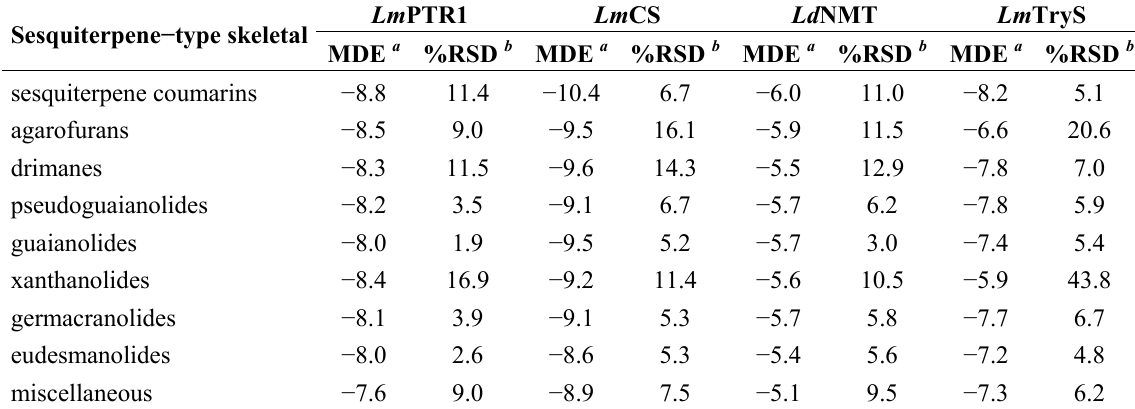
Table 3. Mean values of docking energies (kcal/mol) and standard deviation for each skeletal type of sesquiterpenes with Leishmania enzyme